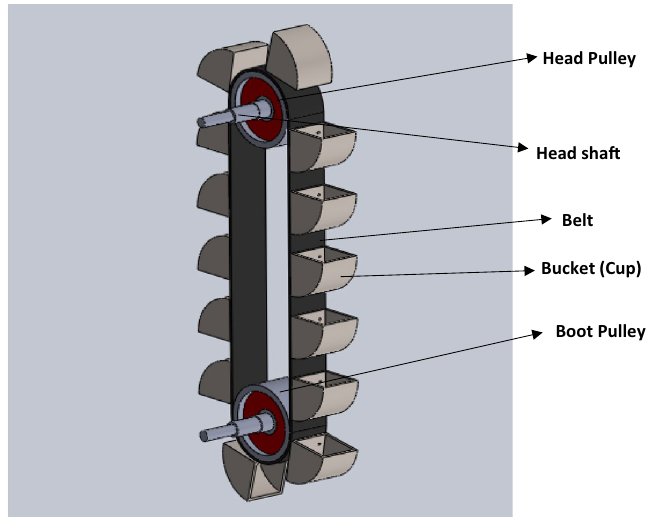
Figure 1. Bucket belt elevator